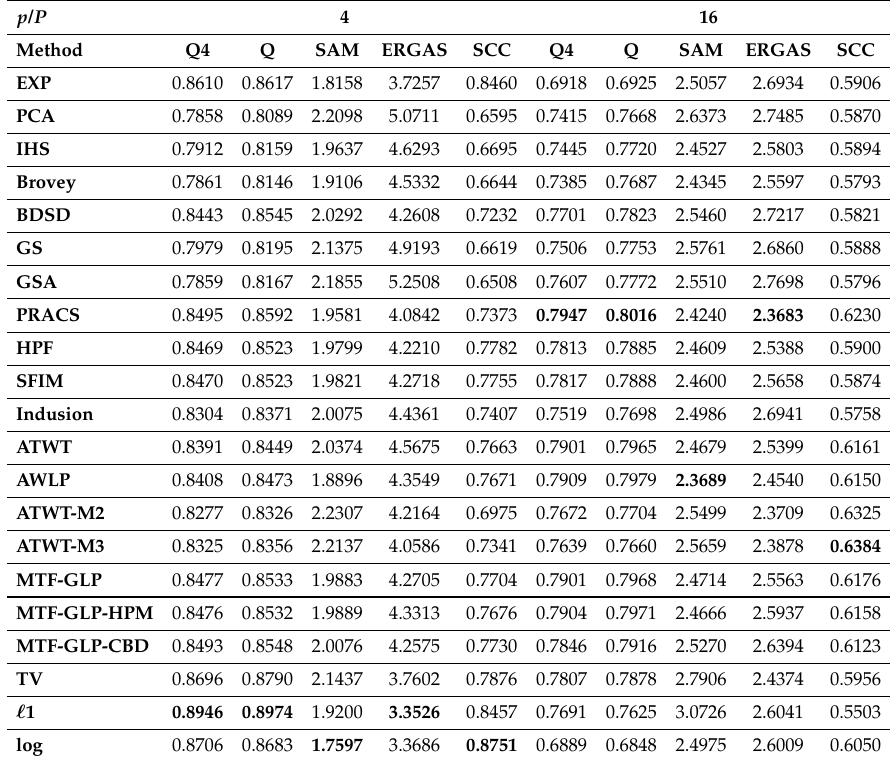
Table 10. Quantitative results using Wald’s protocol on the FORMOSAT-2 Salon-de-Provence image. Bold values indicate the best score.